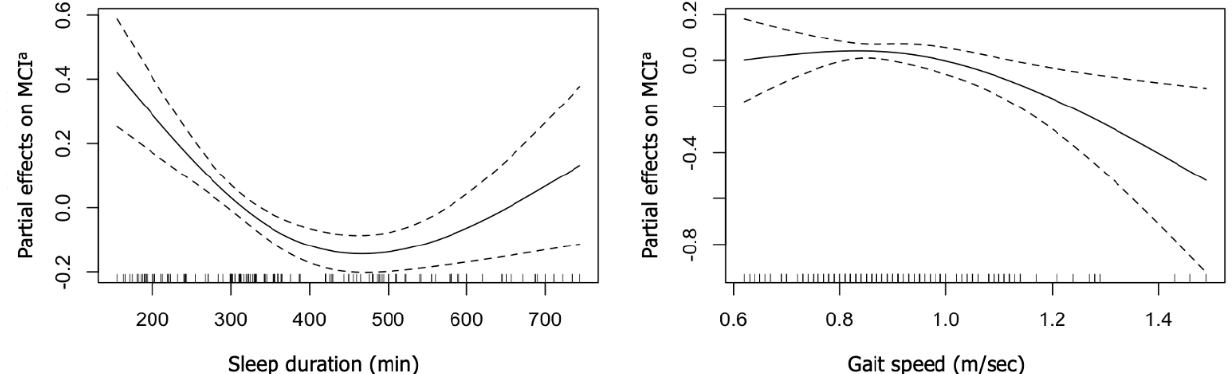
Figure 1. Estimated dose–response relationships of sleep duration and gait speed with risks of MCI in the total sample. Adjusted for age, sex, marital status, education, albumin levels, living status, smoking history, alcohol use, nutrition status, body mass index, and daily physical activity >3 METs. MCI a , mild cognitive impairment.